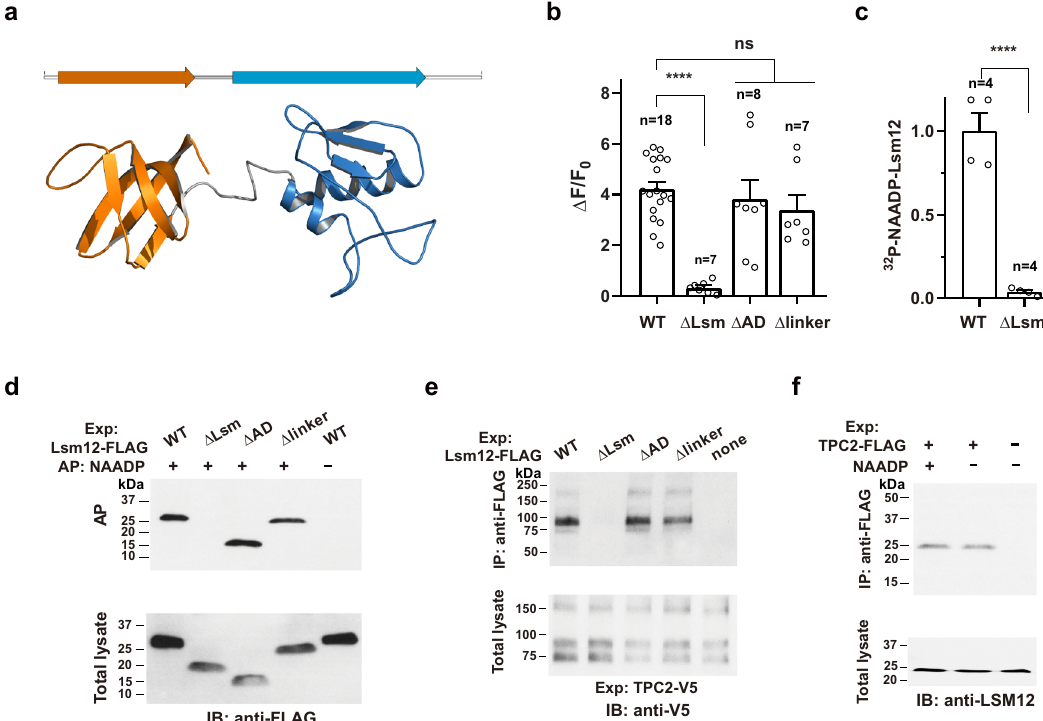
Fig. 4 Lsm12 functions in NAADP signaling via its Lsm domain. a Putative domain assignment and predicted 3D structural model for Lsm12 (GenBank: AAH44587.1). Region assignment: Lsm domain, residues 4 – 67; Linker, residues 68 – 84; putative AD domain, residues 85 – 170. The structure was drawn with a previously created model (https://swissmodel.expasy.org/repository/uniprot/Q3MHD2) 42 . b Averaged NAADP-induced changes in Ca 2 + indicator fl uorescence in Lsm12-KO cells transfection with Lsm12 WT and mutant constructs. c Speci fi c binding between 32 P-NAADP and FLAG-tagged Lsm12 WT and Δ Lsm proteins that were transiently expressed in Lsm12-KO cells and immunoprecipitated by an anti-FLAG antibody. d Immunoblot of Lsm12 WT and mutants pulled down by immobilized NAADP. e Co-immunoprecipitation between TPC2 and Lsm12 mutants. f Co-immunoprecipitation between TPC2 and Lsm12 in the absence or presence of 100 µ M NAADP. Exp expression. Data were presented as mean value ± SEM. Unpaired Student ’ s t - test (two-tailed) was used to calculate p values. **** is for p value ≤